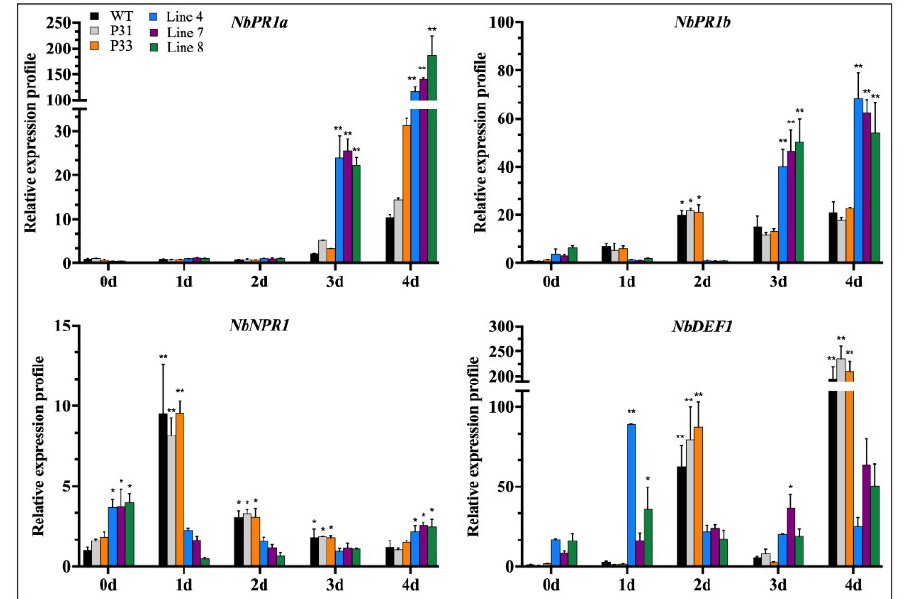
Figure 11. The expression of defense-related genes after inoculation with P. capsici in transgenic (line 4, line 7, and line 8), empty vector (P31 and P33), and wild-type lines. The expression levels were analyzed between the transgenic lines (line 4, line 7, and line 8) and the wild-type and empty vector transgenic lines (P31 and P33) at the same time point using the least significant difference (LSD). * represents significant difference at p ≤ 0.05, and ** represents highly significant differences at p ≤ 0.01. Mean values and SEs for three replicates are shown.